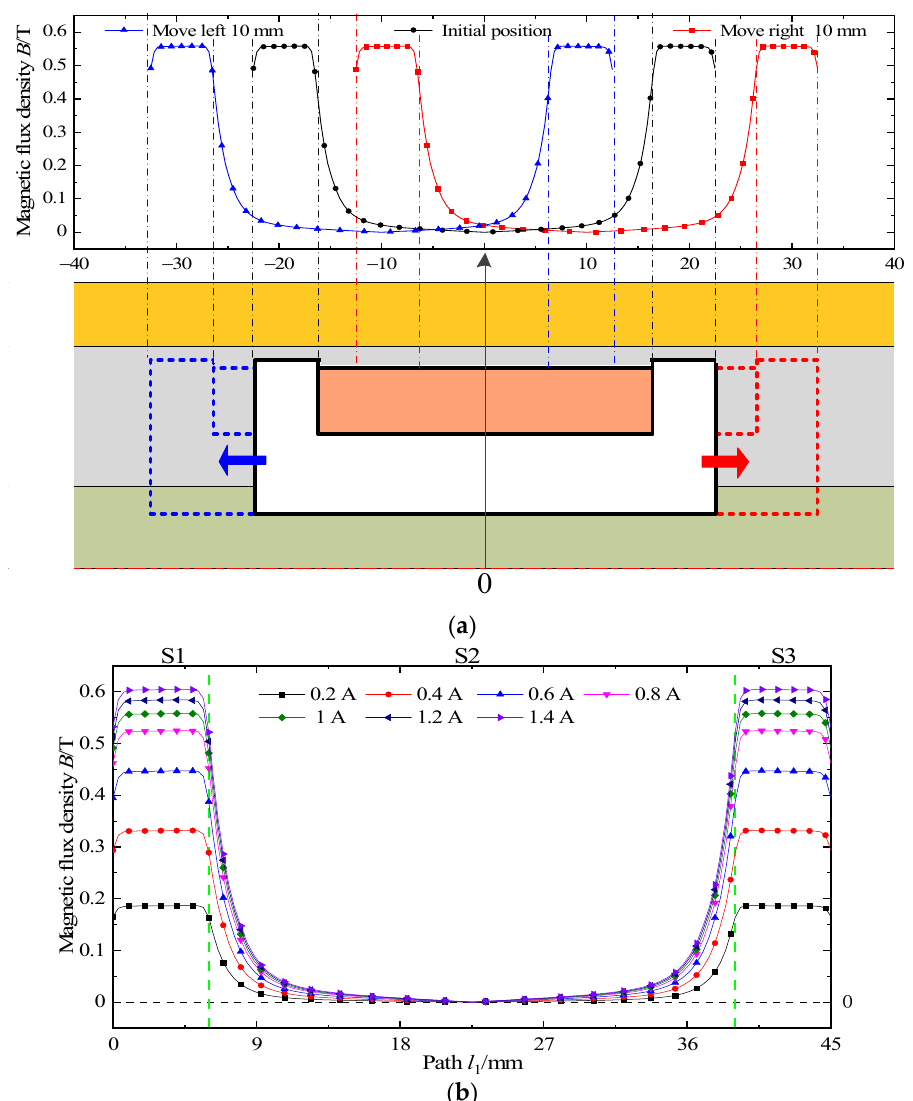
Figure 8. Distribution of magnetic flux density along the path. ( a ) Different positions of the damper piston, ( b ) different excitation currents. the damper piston, ( b ) different excitation